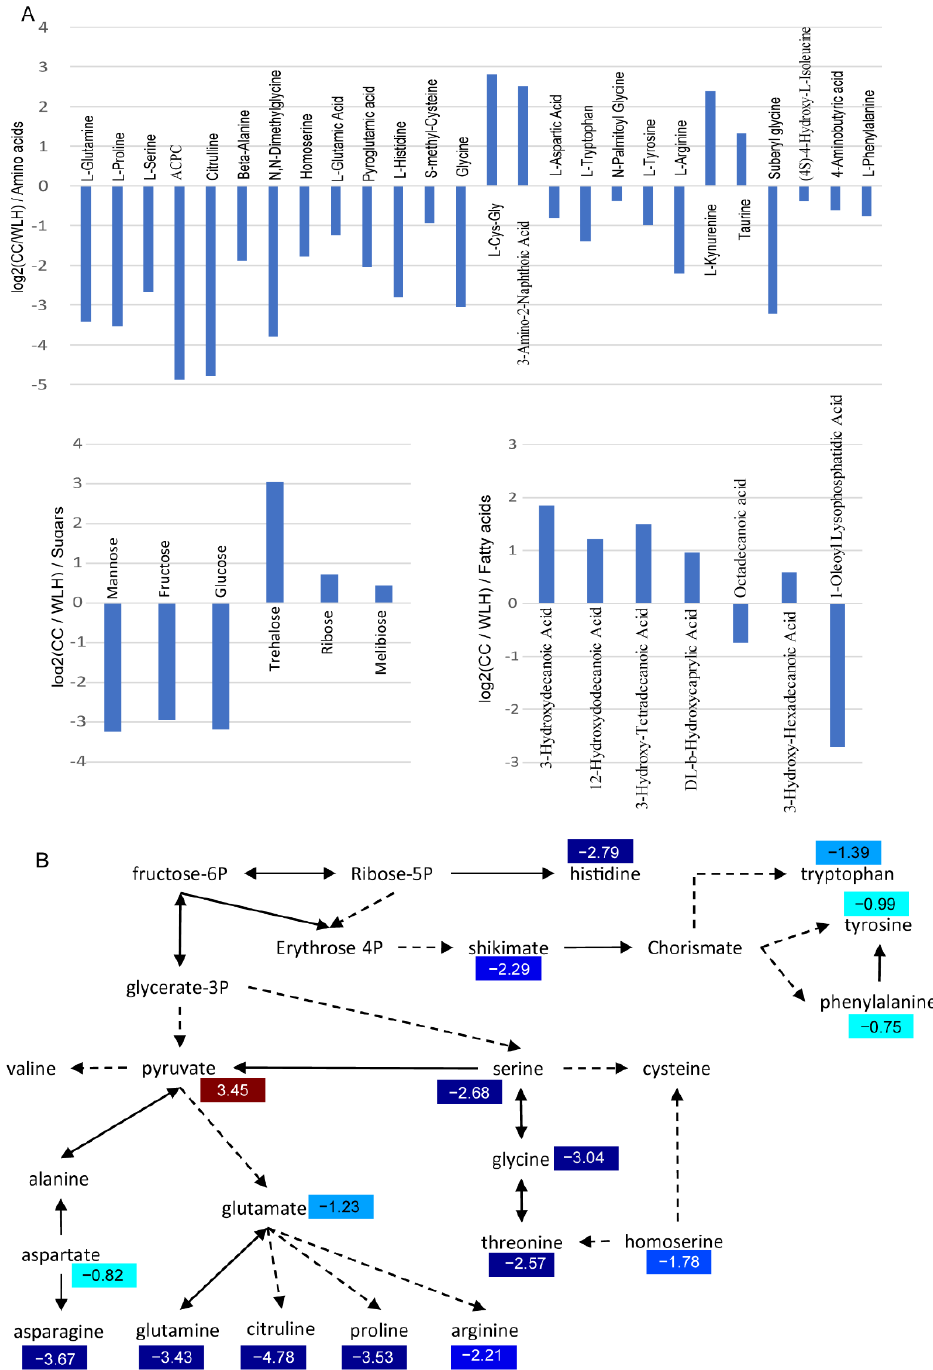
Figure 3. Differentially accumulated metabolites (DAMs) of amino acids, sugars, and fatty acids. ( A ) Change of metabolite indicated by Log2 (Fold change). ACPC, 1-Aminocyclopropanecarboxylic Acid. ( B ) DAMs in amino acids biosynthesis pathway (ko01230). Numbers in color indicate a heatmap of log2 (fold change). Fold change, change in A. tuberosum relative to A. hookeri .